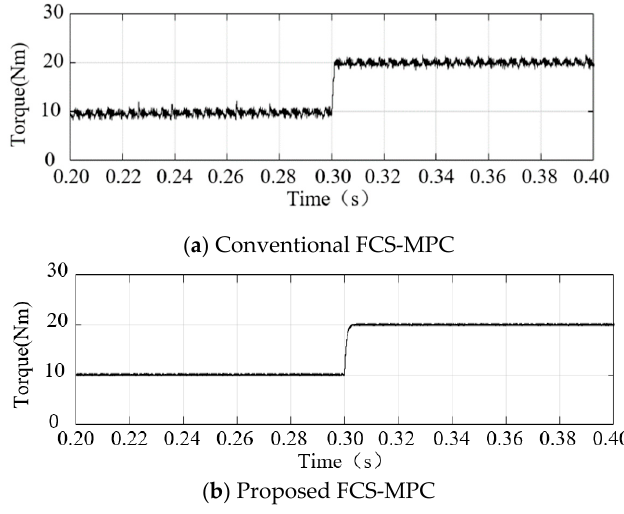
Figure 7. Torque dynamic simulation at t = 0.3 s.